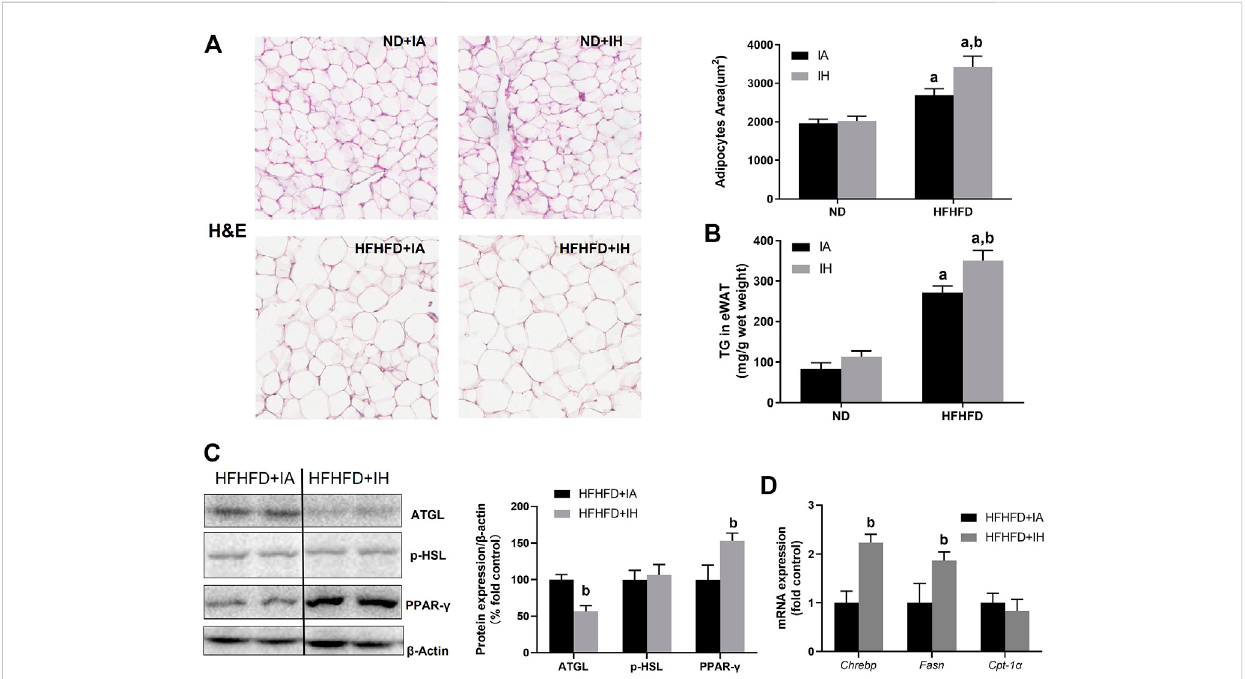
FIGURE 5 IH increased steatosis in eWAT in HFHFD-fed mice. (A) Representative H&E staining of white adipose tissues (eWAT) (×300) and semi quanti fi cation ofadipocytesizeareshown. (B) TGconcentrationofeWATwasmeasuredasdescribedinMaterialandMethods. (C) Representativewesternblotanalyses anddensitometricanalysisforlipidmetabolism-associatedproteinsinadiposetissue:p-HSL,ATGLandPPAR- γ . (D) HepaticmRNAexpressionofChrebp, Fasn, and CPT- α are performed in HFHFD – fed mice. a, p < 0.05 compared to ND control, b, p < 0.05 compared to absence of IH. Samples size per group n = 4 –